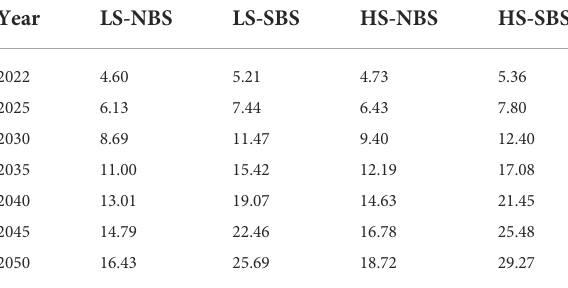
TABLE 6 Critical metal stocks under four scenarios from 2022 to 2050 in China (million